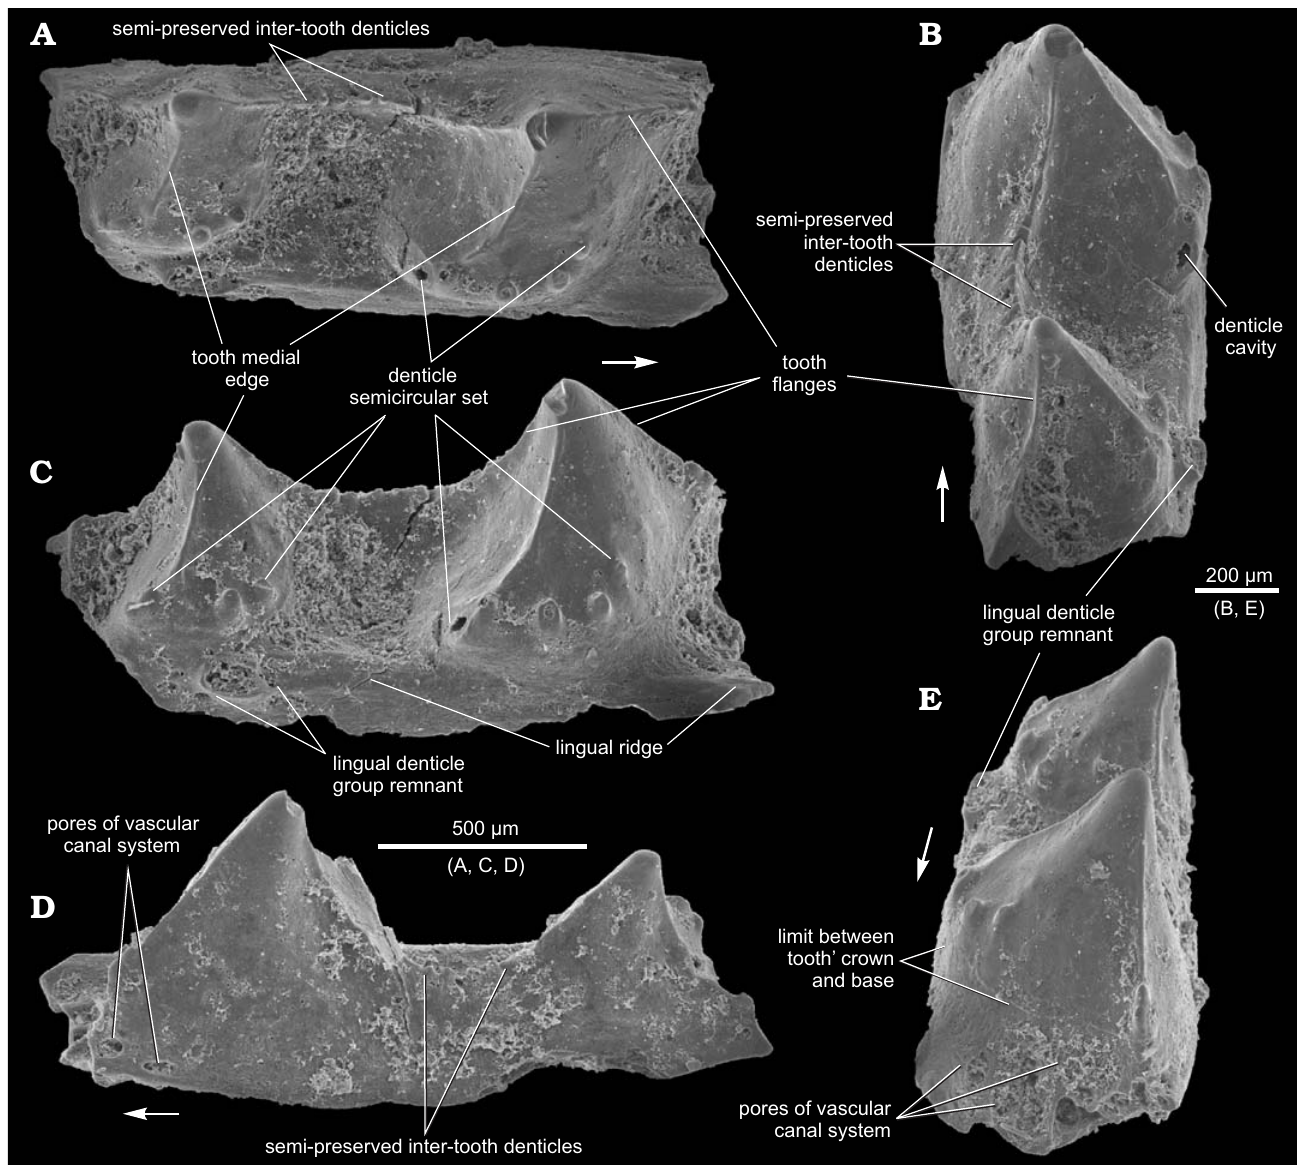
Fig. 3. Ischnacanthiform fish Drygantacanthus semirotunda gen. et sp. nov., the holotype, SMNH BP.1581/5, Dniester River opposite Zalishchyky, Zastavna (Chernivtsi) region, Podolia, Ukraine; Upper part of Ivanie Horizon of the Tyver Series, Lower Devonian. Jaw bone fragment in occlusal ( A ), postero-occlusal ( B ), lingual ( C ), lateral ( D ), and antero-occlusal ( E ) views. Arrows indicate rostral Etymology : After the semicircular-like arrangement of the tooth addi- tional dentition. Holotype : SMNH BP.1581/5, a jaw bone fragment, 1.63 mm long, with two teeth of the lateral tooth row.